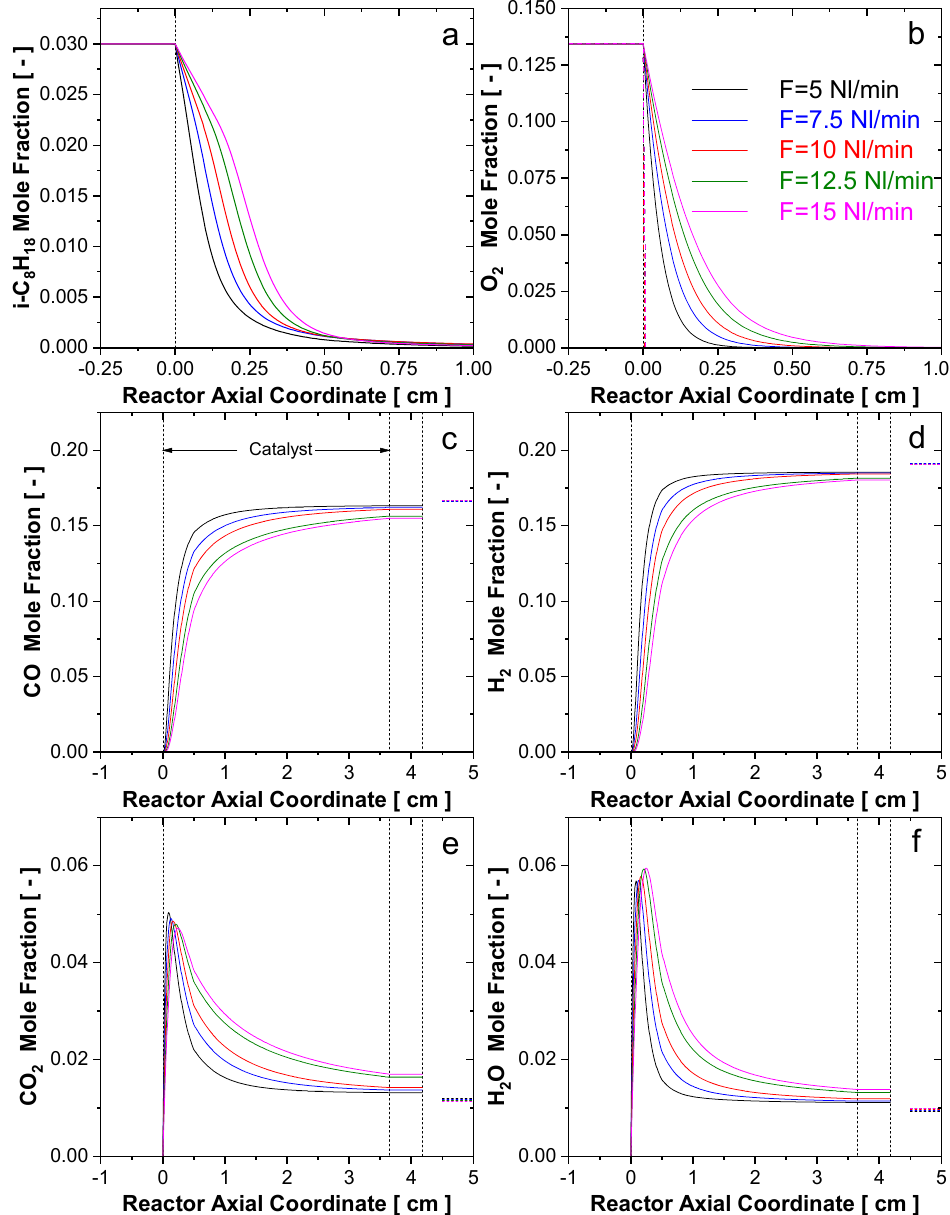
Figure 5. Simulated concentration profiles obtained varying the inlet flow. Feed composition: iC8 = 3%, air with C/O = 0.9 and N 2 complement.